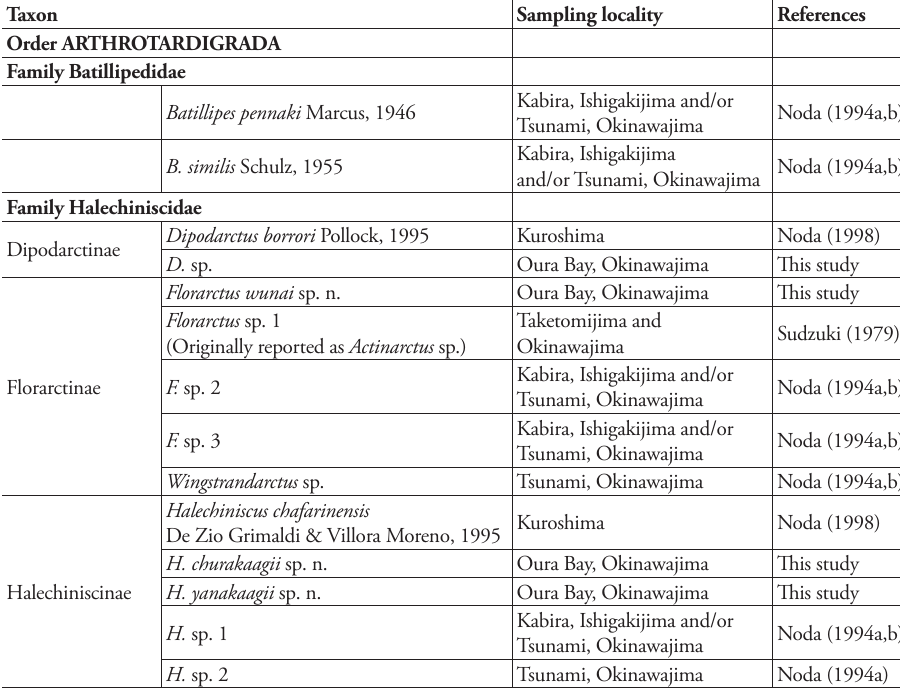
Table 3. Marine tardigrades reported from the Ryukyu